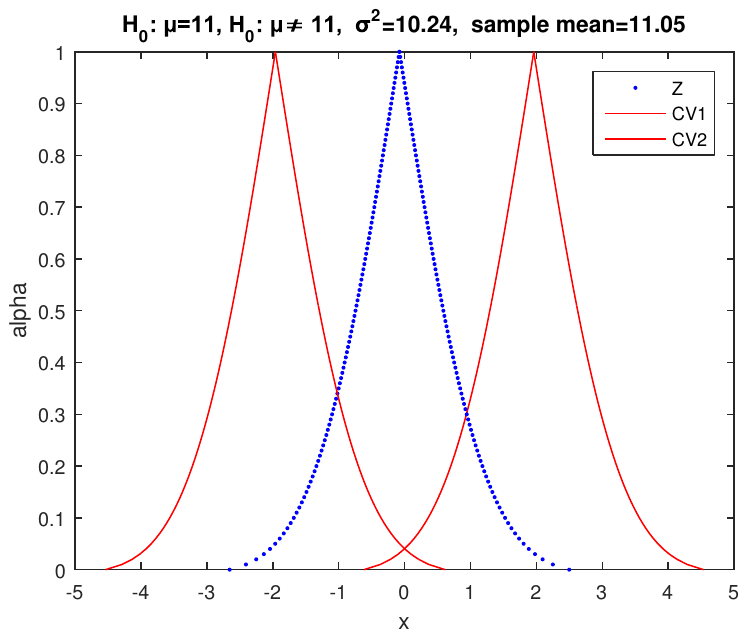
Figure 7. Fuzzy statistic (cid:101) Z and critical values (cid:103) CV i for the respective test of Example 2 in